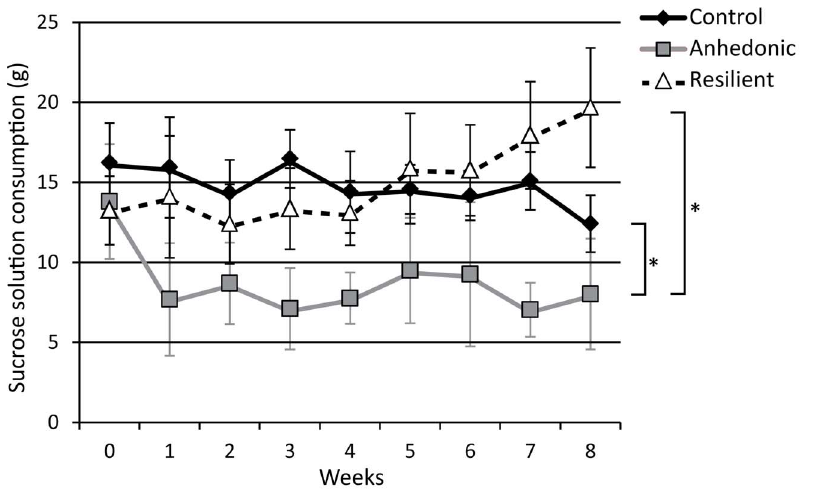
Figure 1. Sucrose consumption test. The rats were presented with a sucrose solution (1.5%) for one hour after 14 hours of food and water deprivation in order to evaluate their hedonic state during the CMS procedure (8 weeks). The studied animals showed a significant decrease of sucrose consumption in the anhedonic-like group, whereas the resilient animals showed no change compared with the control animals. The analysis was performed with two-way ANOVA for repeated measures. The data are presented as mean 6 SD. *p , .001. The figure was adapted from Delgado y Palacios et al. [18].